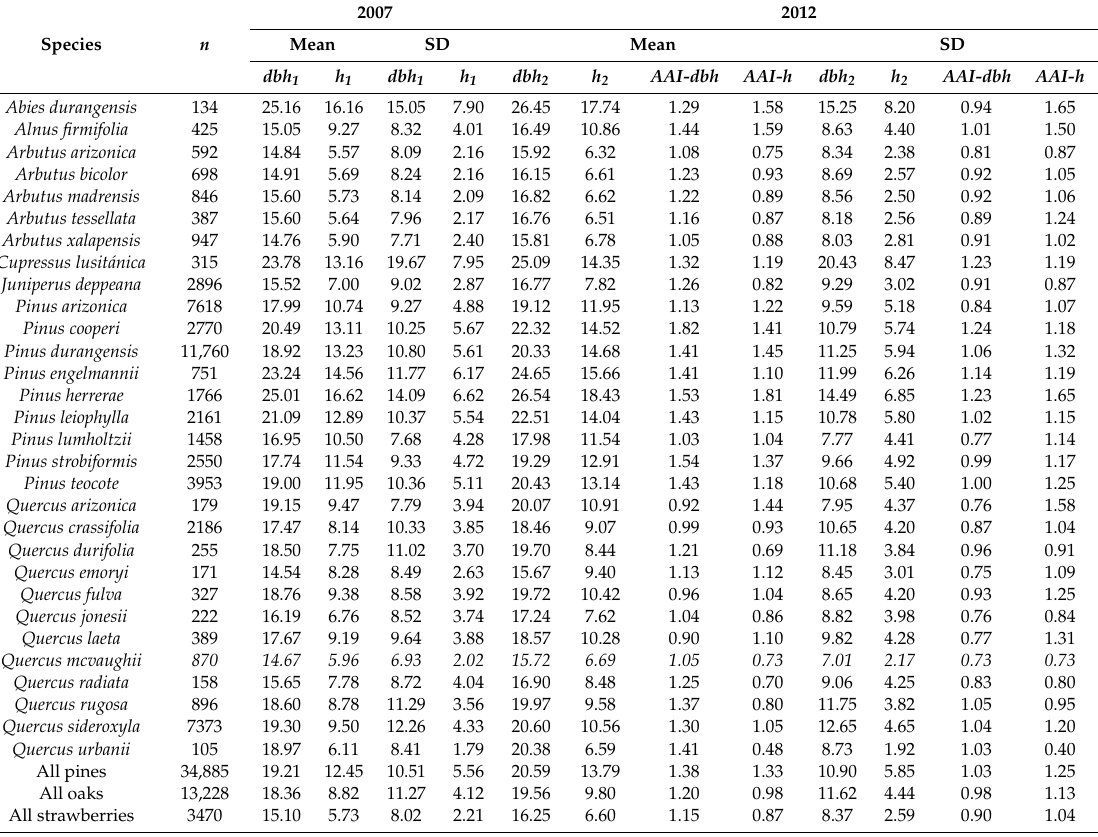
Table 2. Summary statistics of the tree species and species groups used to develop the diameter and height growth